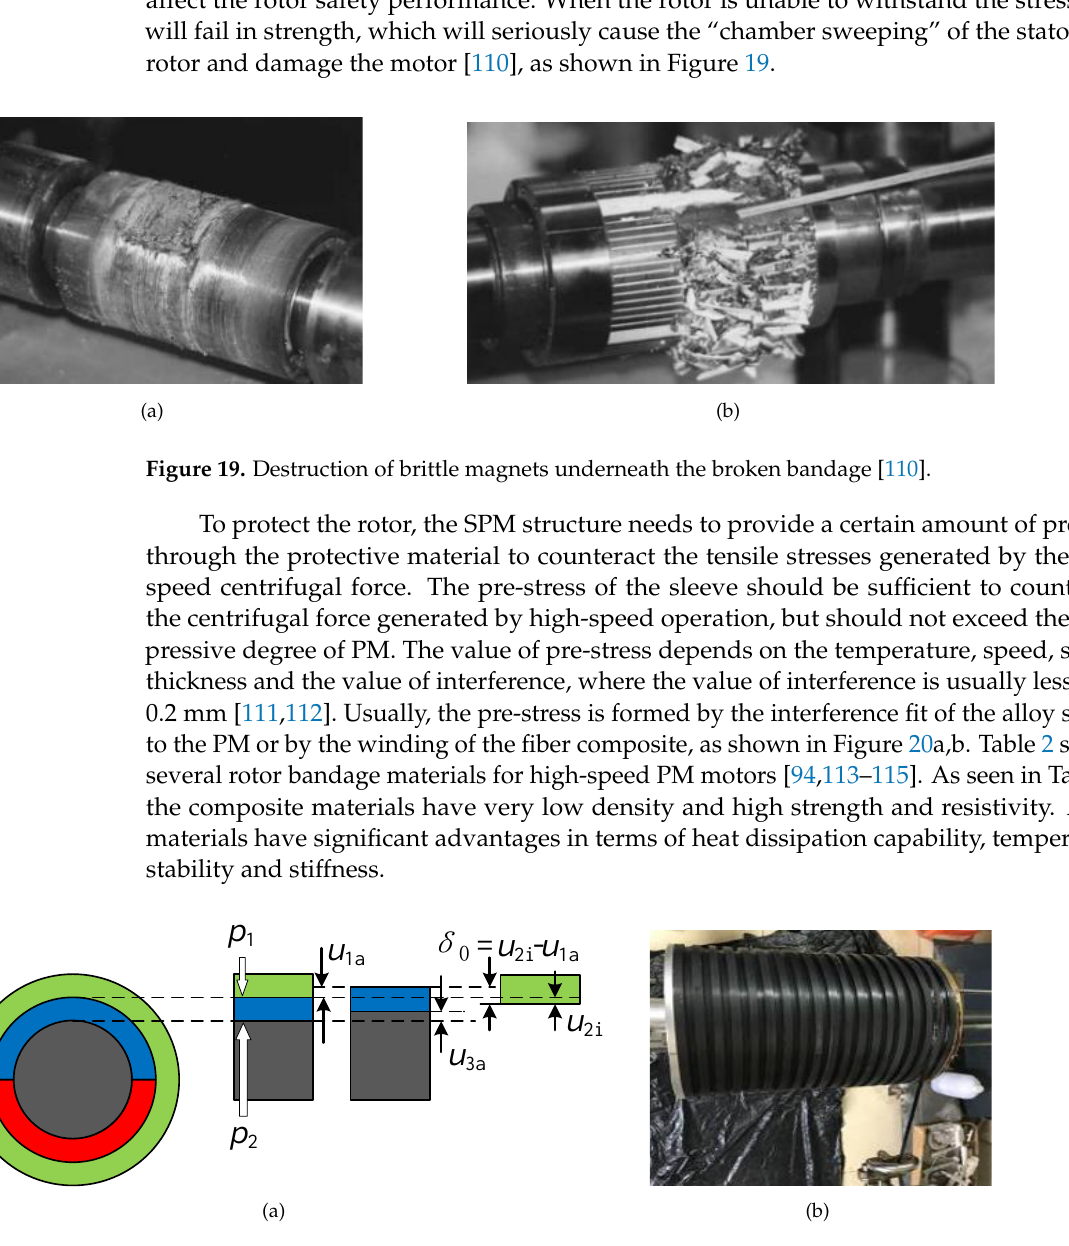
Figure 20. Two common permanent magnet protection measures: ( a ) Three-layer interference fit. The meanings of the characters in the figure are detailed in [116]; ( b ) Winding process of carbon fiber composites